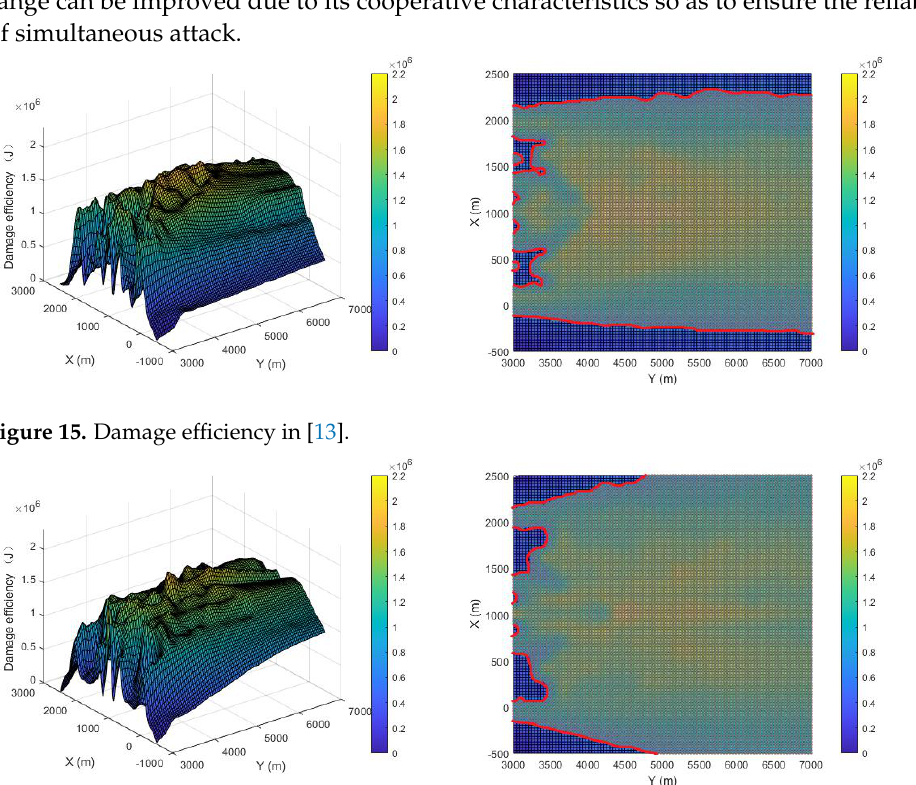
Figure 16. Damage efficiency in [13].